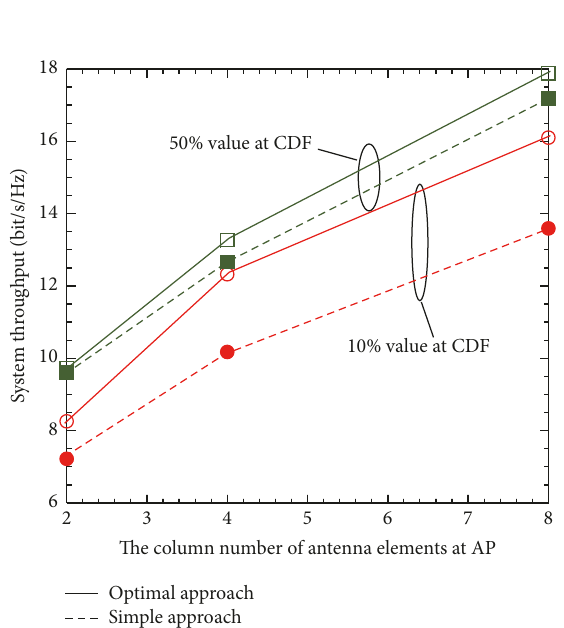
Figure 13: System throughput versus the number of AP antenna elements of vertical